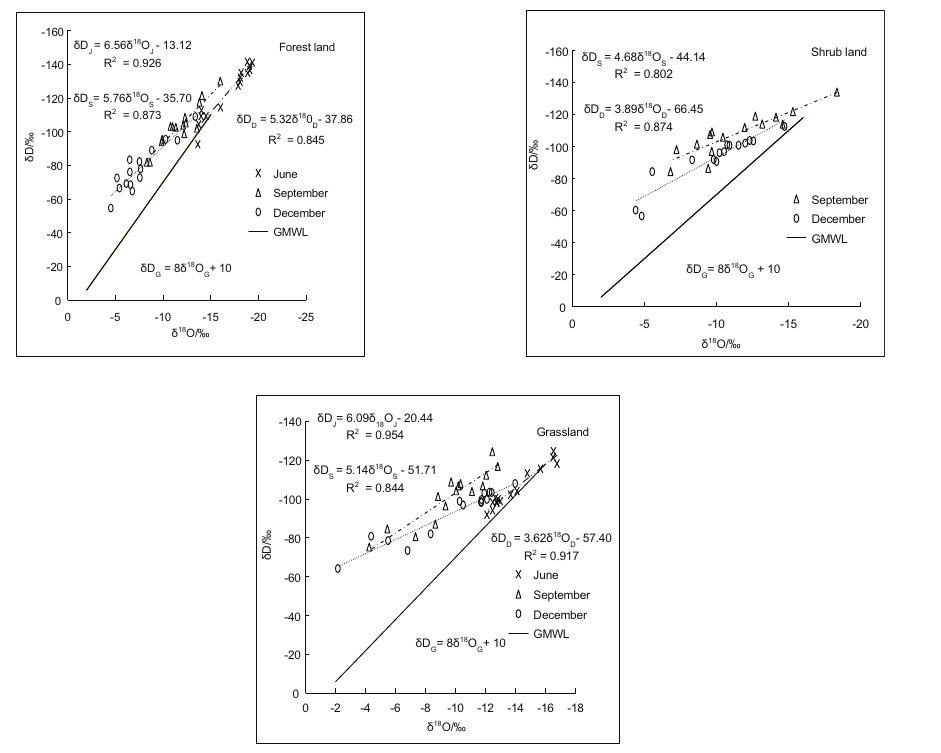
Figure 3: Characteristics of isotope ratio of di ff erent soil waters.